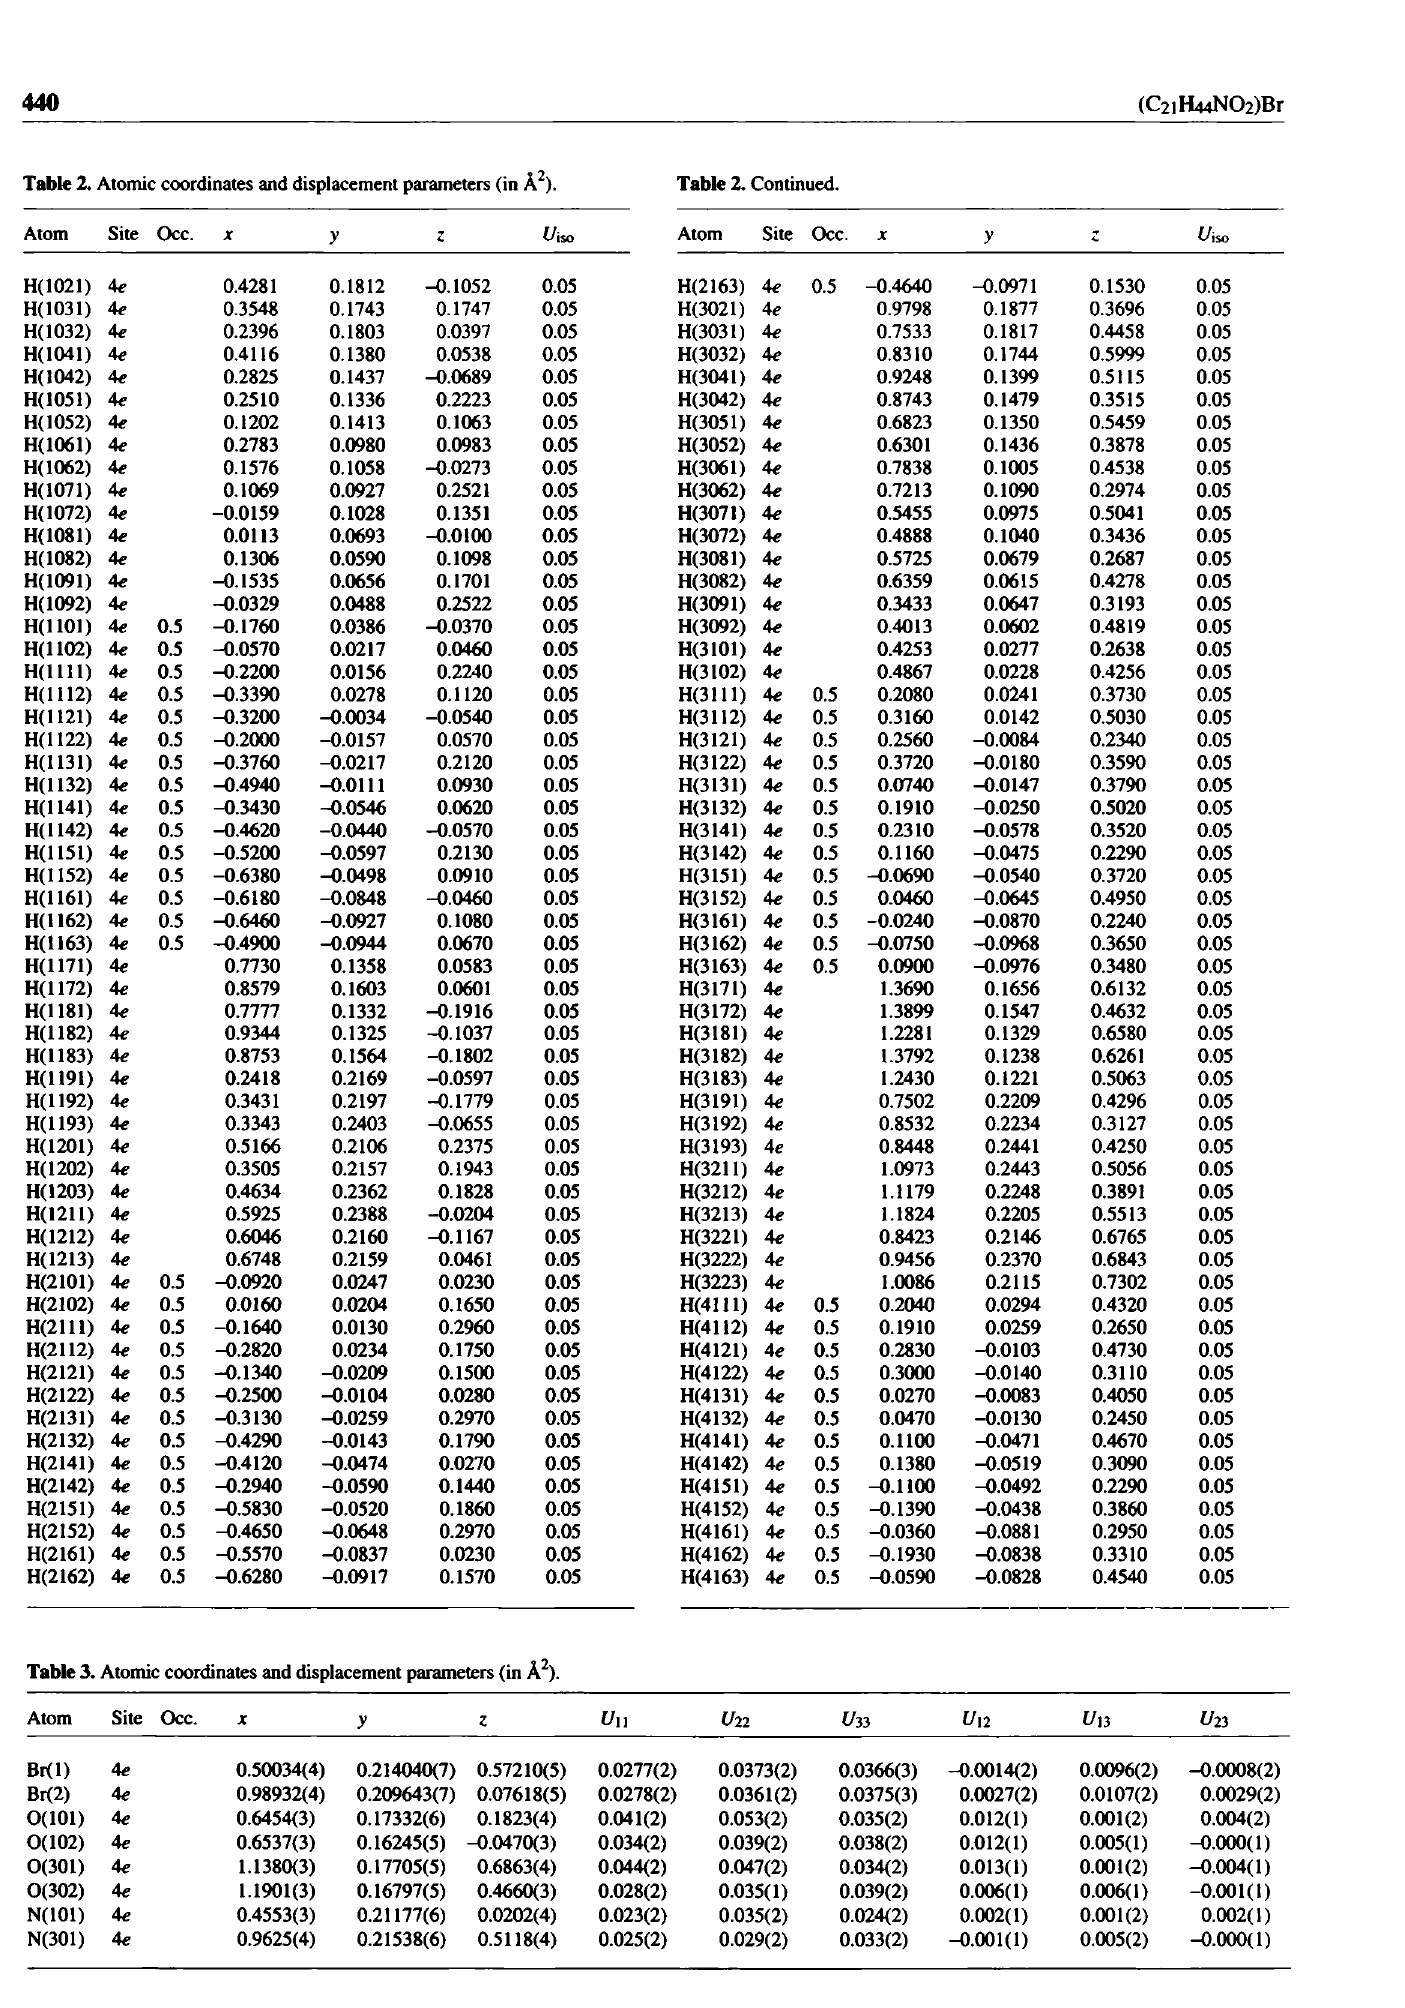
Table 3. Atomic coordinates and displacement parameters (in Ä 2